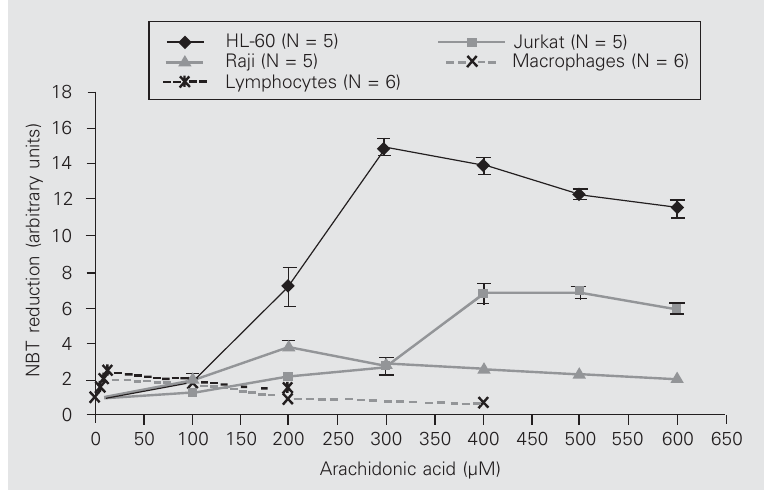
4-5.Figure 2. Nitroblue tetrazolium (NBT) reduction induced by different arachidonic acid concentrations. The experimental conditions are the same as those described in the legend to Figure 1. Results are reported as mean ± SD relative absorbance in relation to the value at time zero. The number of samples is indicated by